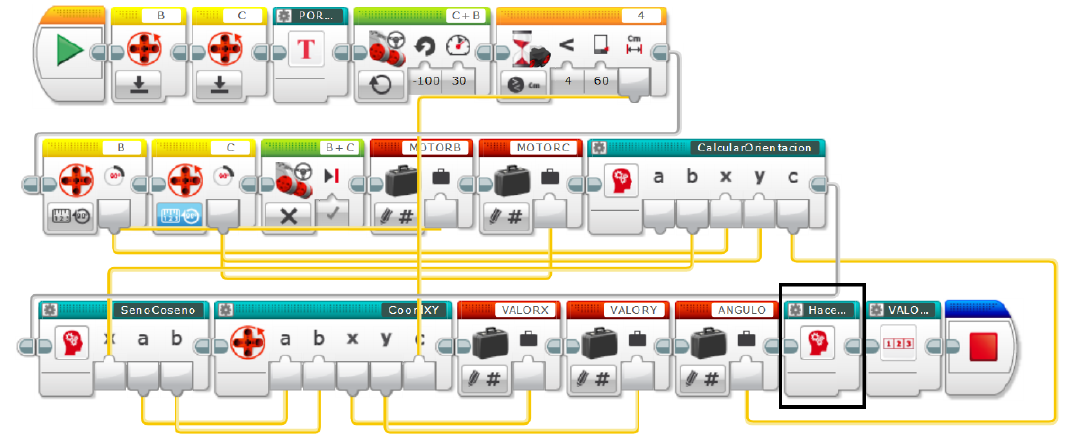
Figure 5. Program for the physical visualization of the Euclidean, Taxicab and Infinity